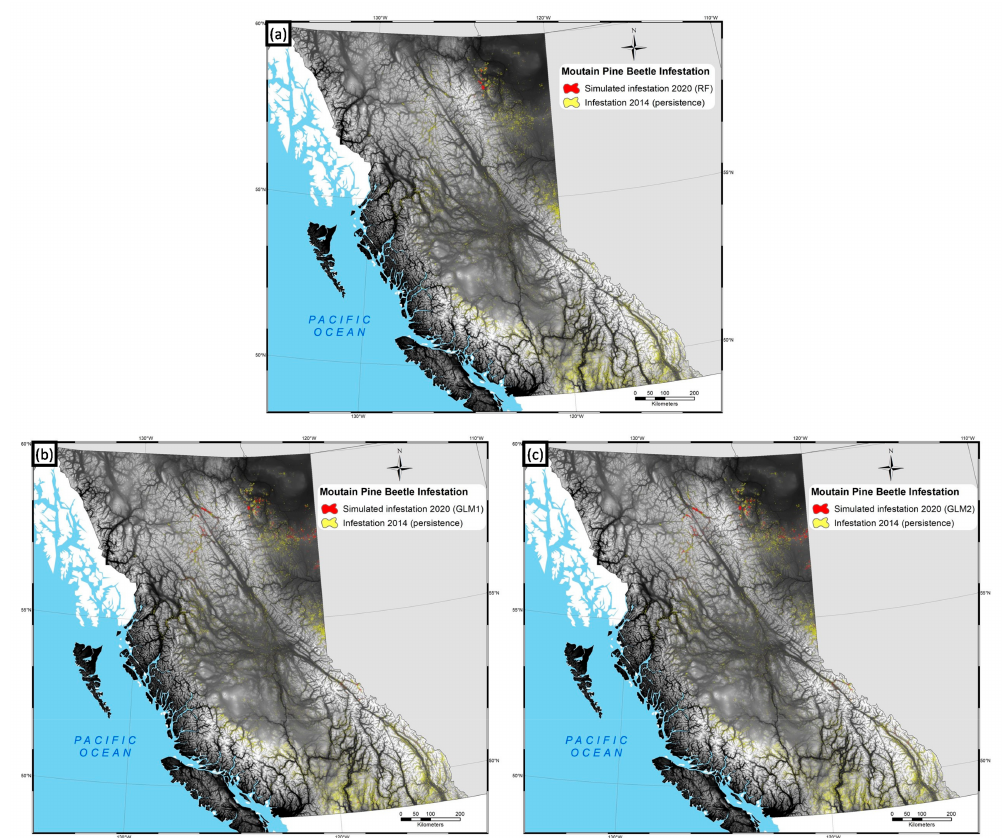
Figure 5. Predictions of changes in study area from 2014 to 2020. Algorithms: ( a ) random forest (RF); ( b ) binomial regression (GLM1); ( c ) binomial regression with parabolic elevation